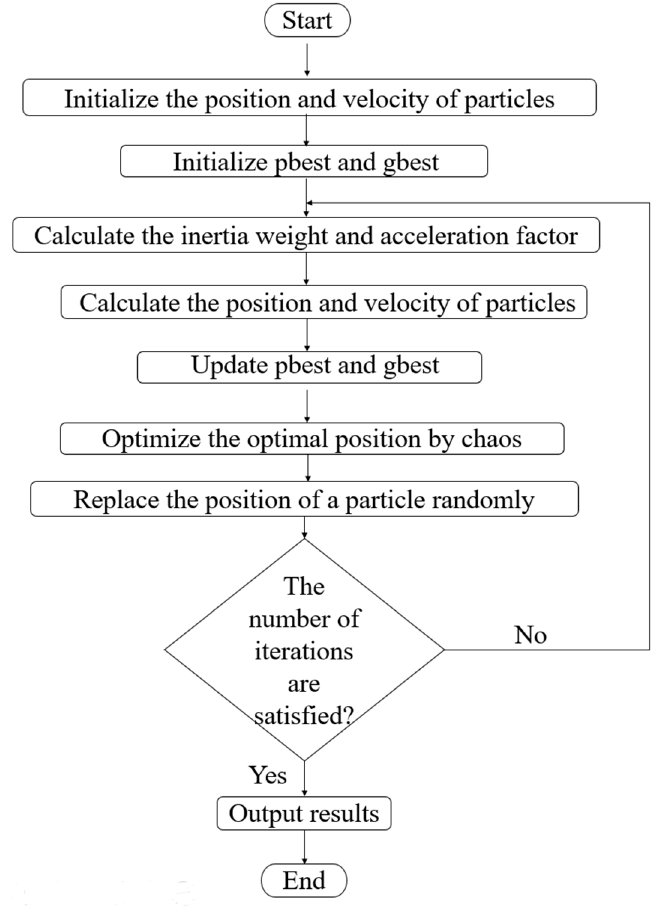
Figure 5. Flow chart of improved PSO algorithm.